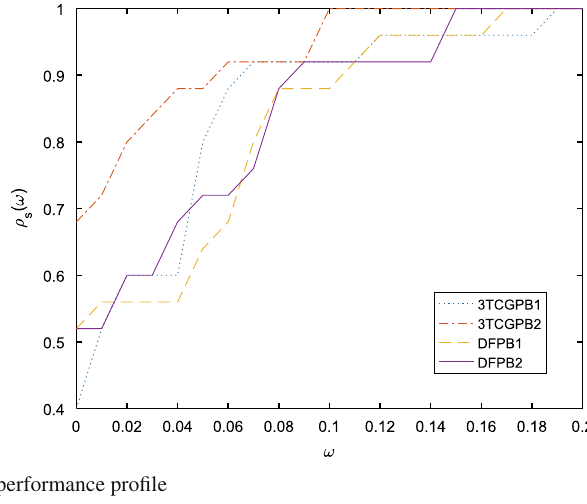
Fig. 2 Function evaluations performance profile